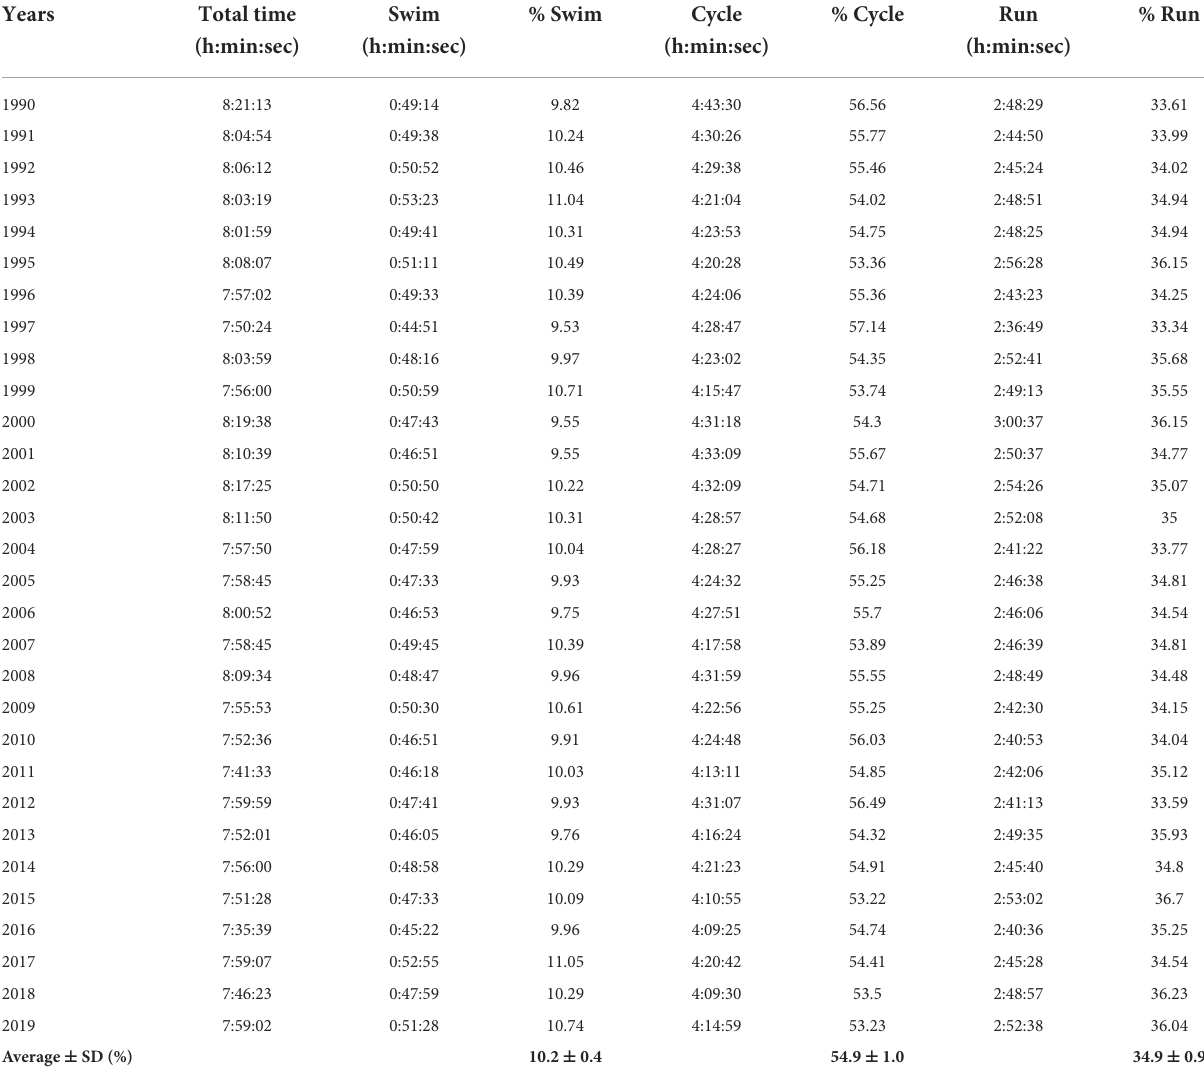
TABLE 4 Time for each discipline of the winners of the Ironman TM Challenge Roth triathlon from 1990 to 2019 in relation to total racing time.